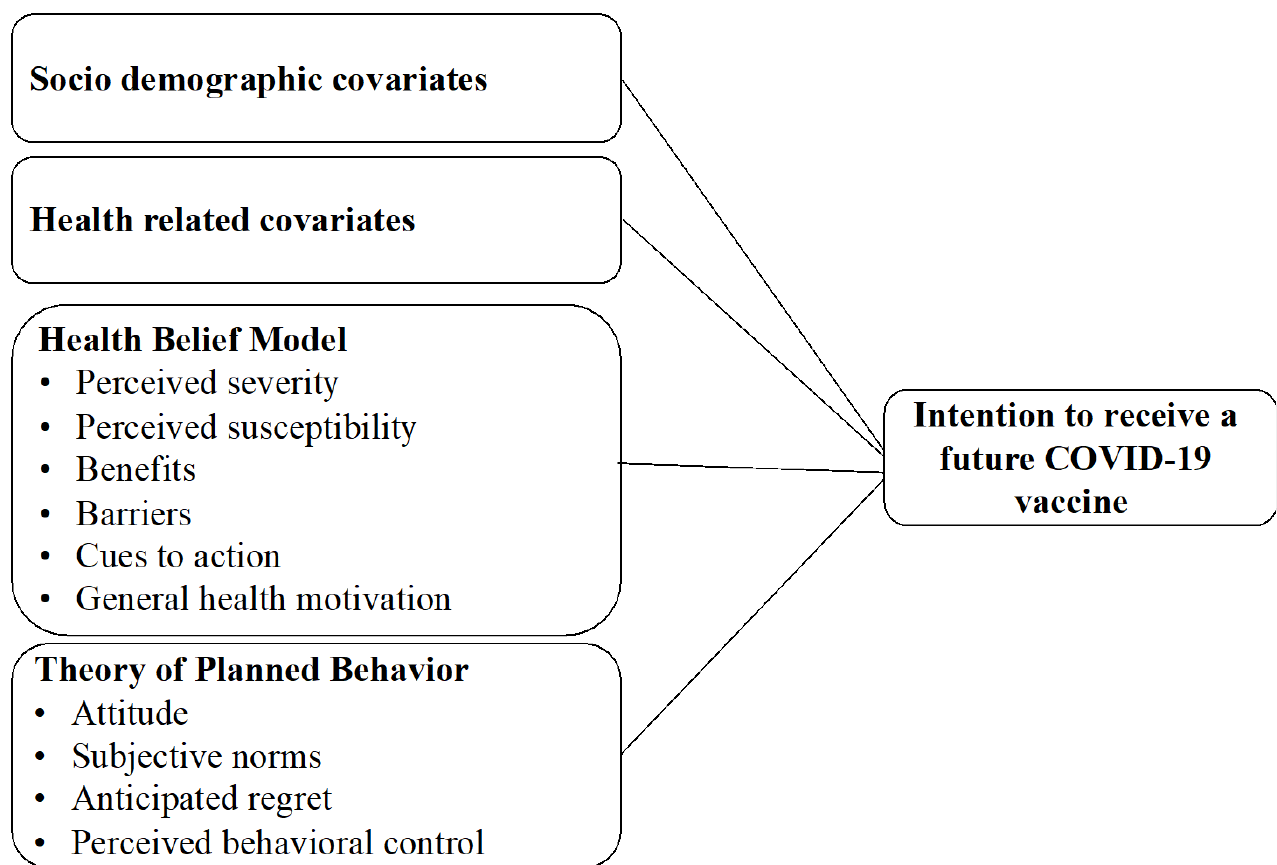
Figure 1. Conceptual Framework for the hypothesized predictors of intention to receive a COVID-19 vaccine.